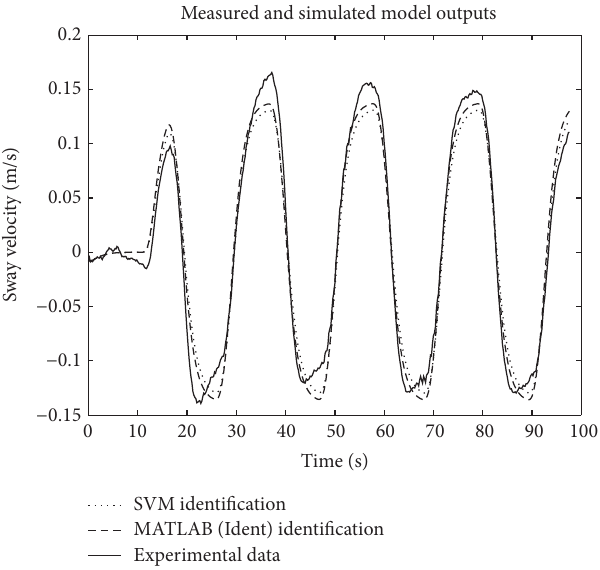
Figure 11: Comparison between the experimental sway velocity (solid line), the sway velocity of the LS-SVM identification model (dotted line), and the one of the identification model obtained with the Ident tool of MATLAB (dashed line) for a 20/20 degree zig-zag